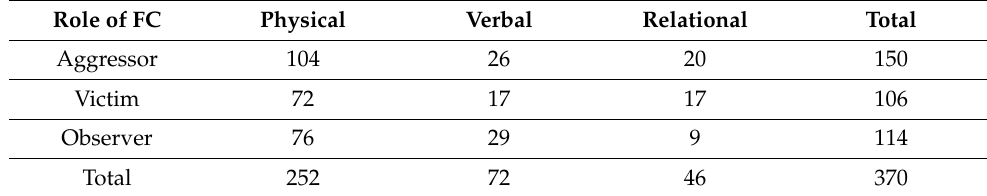
Table 1. Number of times each type of aggression was observed by the focal child (FC) role. Role of FC Physical Verbal Relational Total Aggressor 104 26 150 Victim 72 106 Observer 76 114 Total 252 72 46